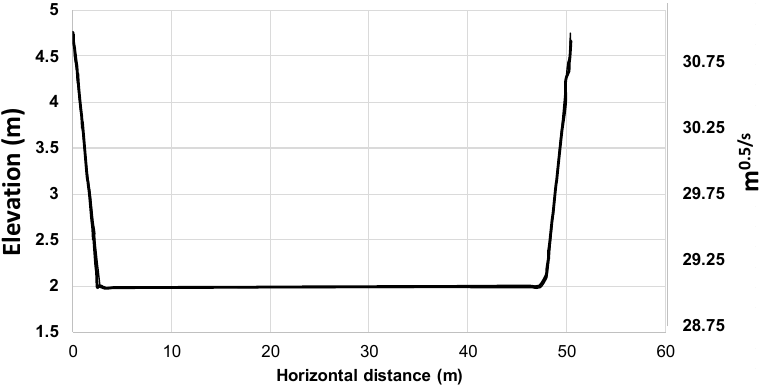
Figure 5. Sediment transport model simulation results .